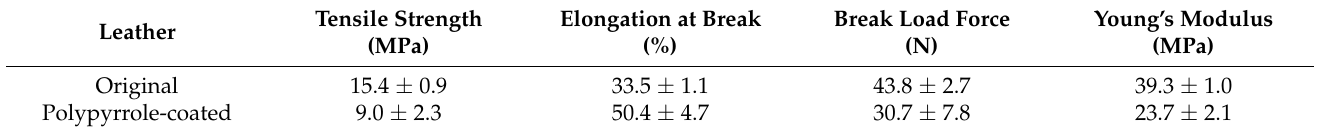
Table 3. Mechanical properties of the original leather and the leather coated with polypyrrole in the presence of poly( N -vinylpyrrolidone) and crystal violet.